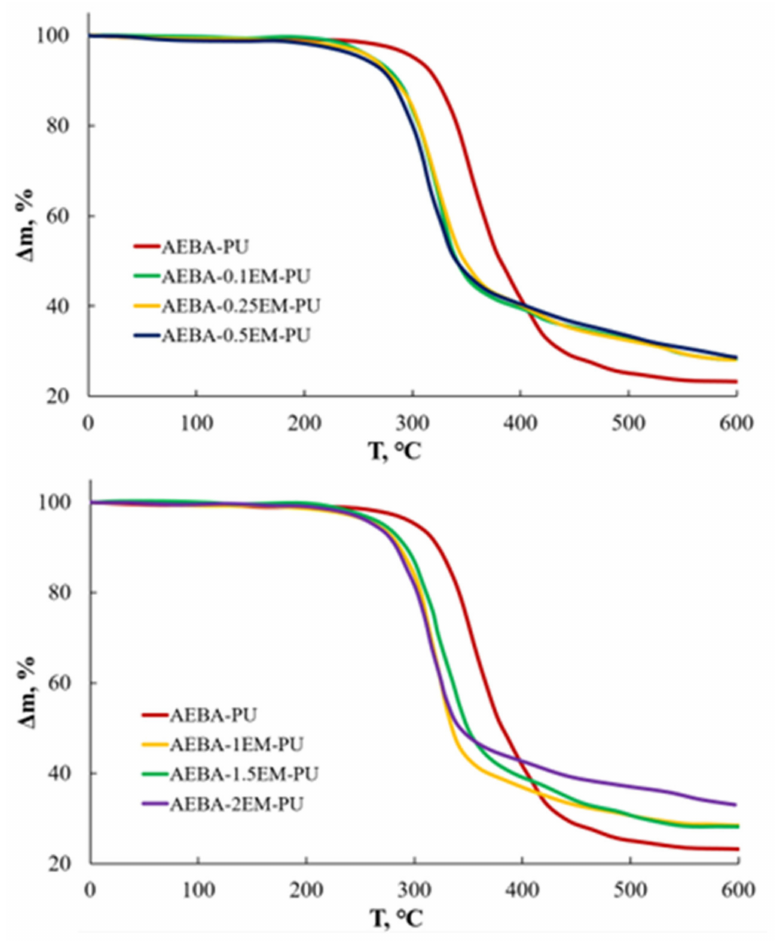
Figure 9. TGA curves for AEBA-PU and AEBA-EM-PU under